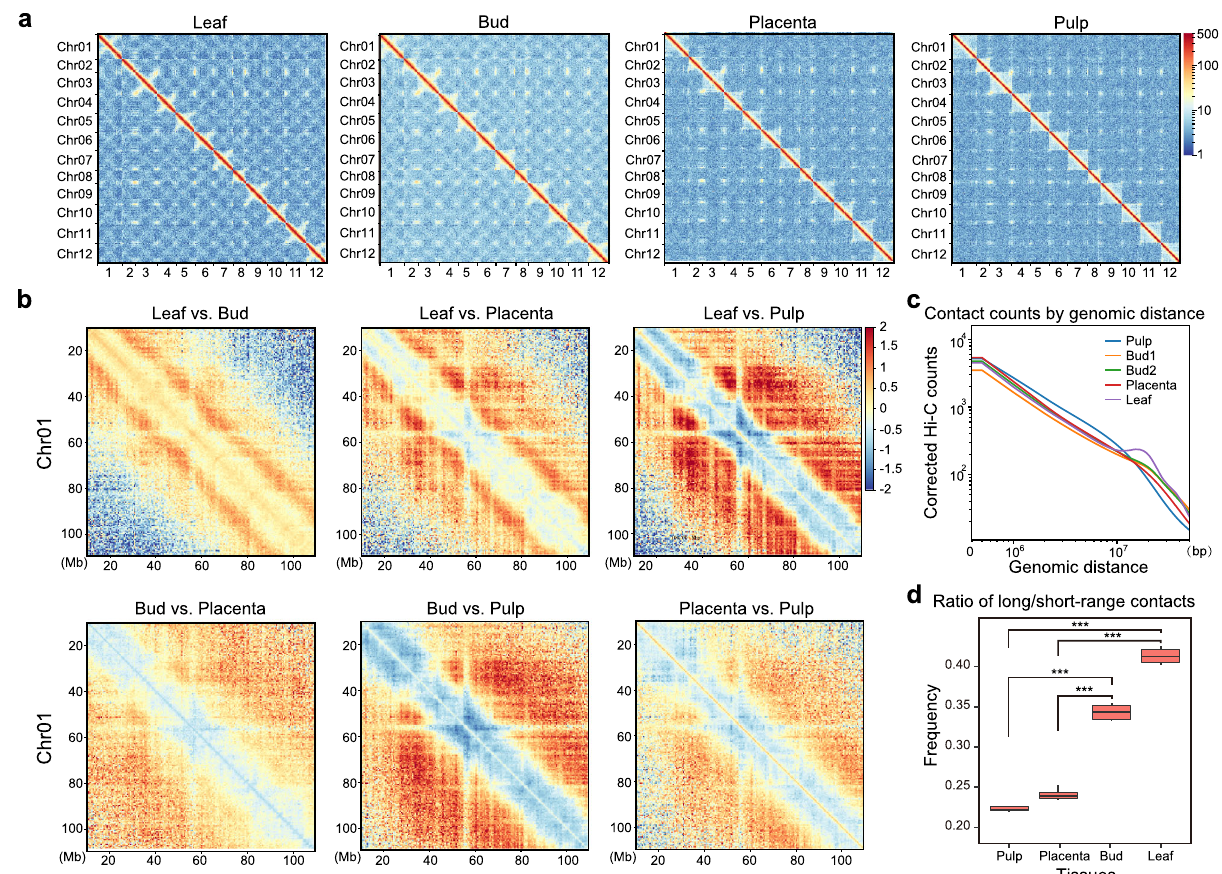
Fig. 1 Hi-C interaction matrices generated from four tissues of C. annuum . a Genome-wide normalized and corrected Hi-C maps (HiCExplorer) at 500 kb resolution. In the leaf and bud, an X-shaped trans-interaction signal appears within each chromosome, while it is weaker or not evident in contact maps of pulp and placenta. See also Juicer Hi-C maps in Supplementary Fig. 7b. b The log 2 -transformed ratio of Hi-C matrices between tissues. Red designates enrichment in the fi rst tissue and blue depletion. c The genomic distance vs. contact counts plot using Hi-C matrices at 500 kb resolution. Leaf and Bud show enrichment of long-range contacts (>20 Mb) than pulp and placenta. Only samples in the fi rst batch were shown. See samples in the second batch in Supplementary Fig. 7c and results based on Juicer Hi-C maps in Supplementary Fig. 7d. d The ratio of long-range (>20 Mb) versus short-range contacts. The sample size for the boxplot is the number of chromosomes ( n = 12). This ratio is signi fi cantly higher in leaf and bud compared to pulp and placenta. The boxplot represents the median (band inside the box), fi rst and third quartiles. Whiskers extend to 1.5 times the interquartile range (IQR). P values (*** p < 0.0005) were derived from two-side Wilcoxon matched-pairs signed-rank tests. For results from juicer Hi-C maps, see Supplementary Fig. 7e. Source Data underlying Fig. 1d is provided as a Source Data fi